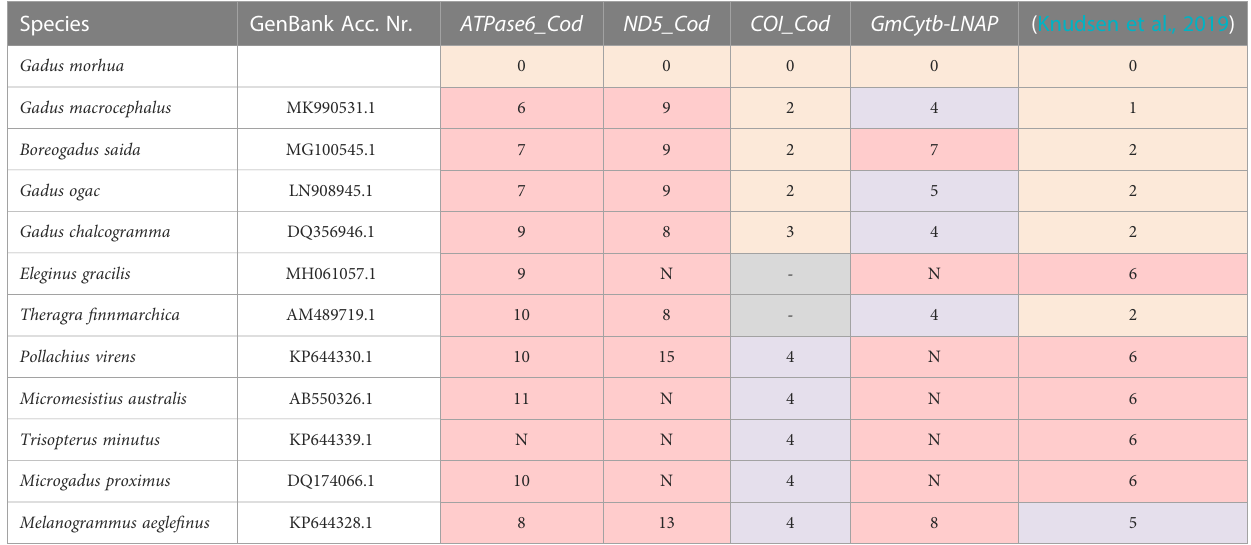
TABLE 1 The number of mutations observed In-silico between the primers designed or published compared to the reference Gadidae mitochondrial genomes. Species GenBank Acc.